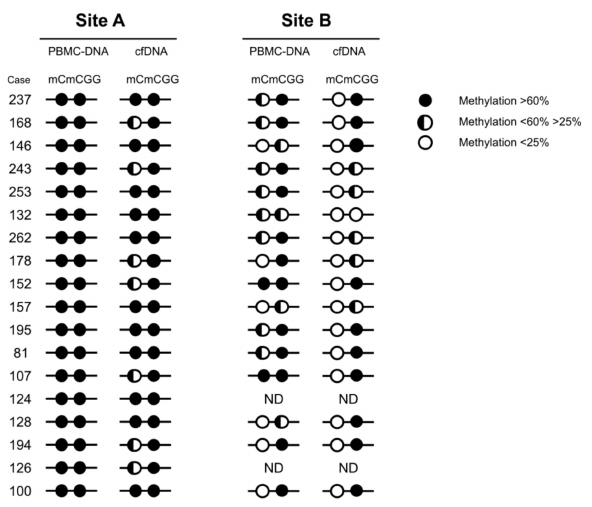
Figure 4. A schematic representation comparing the LINE-1 methylation level between PBMC-DNA and cell-freeDNA(cfDNA)ofesophagealadenocarcinoma(EADC)patients. Eachdotrepresentsonecytosineresidue.